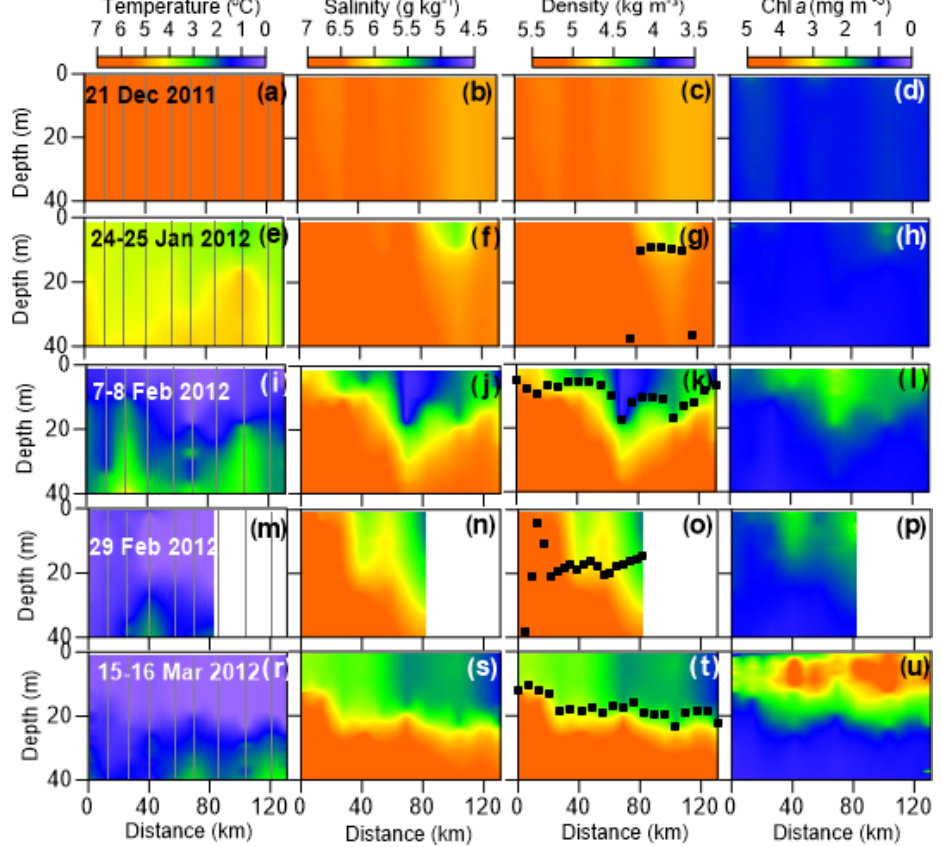
Figure 4. Vertical sections of temperature, salinity, density anomaly, and Chl a along a west-to-east transect in the Gulf of Finland (black dots in Fig. 1) in winter 2011/12. Vertical gray lines mark the location of CTD casts. Black dots on density anomaly panels mark the depth of the upper mixed